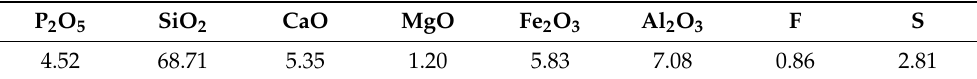
Table 3. Chemical compositions of the solid residue after leaching of REEs from Zhijin phosphate ore by phosphoric acid at T = 55 ◦ C, C H3PO4 = 30%, and duration of 60